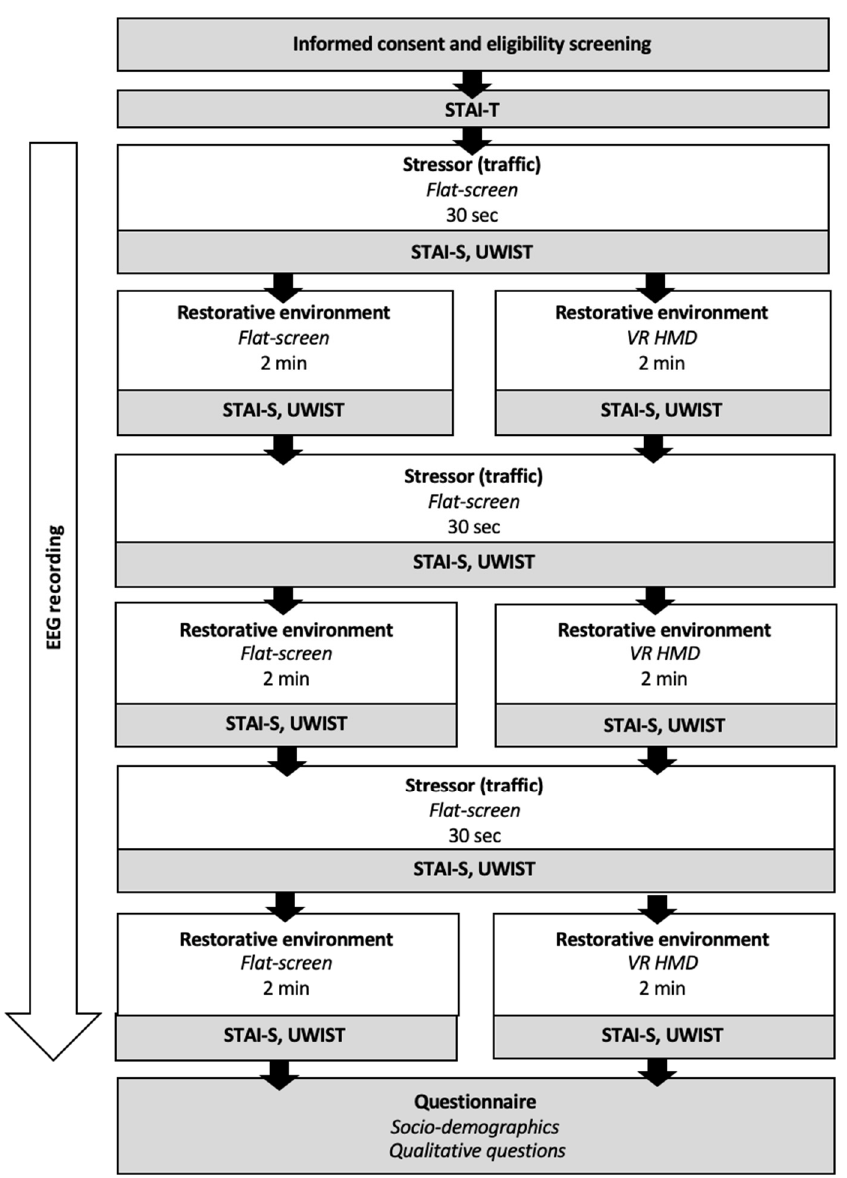
Figure 1. Study design and data collection. Flat-screen = Flat screen computer monitor; VR HMD = Virtual Reality Head-Mounted Display; STAI-T = Subjective Trait Anxiety; STAI-S = Subjective State Anxiety; UWIST = Subjective Stress.